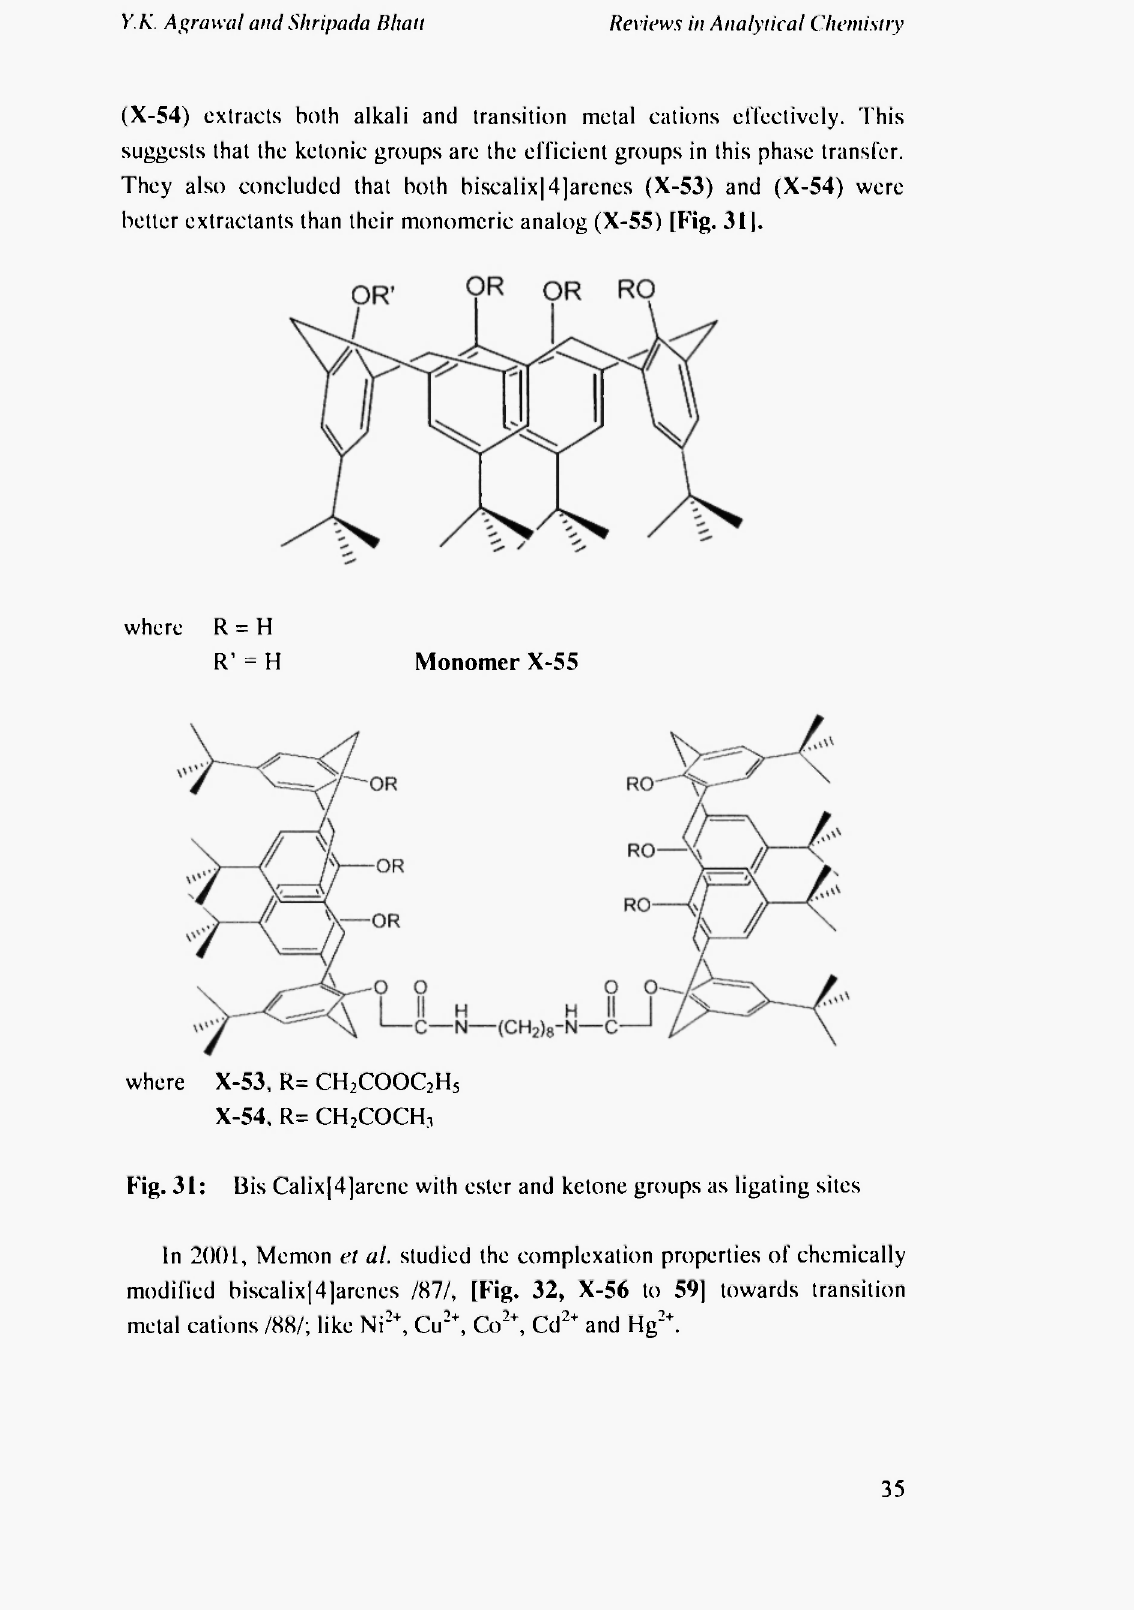
Fig. 31: Bis Calix[4]arene with ester and ketone groups as ligating sites In 2001, Memon et al. studied the complexation properties of chemically modified biscalix|4]arenes /87/, [Fig. 32, X-56 to 59] towards transition metal cations /88/; like Ni 2+ , Cu 2+ , Co 2 *, Cd 2+ and Hg 2+ .